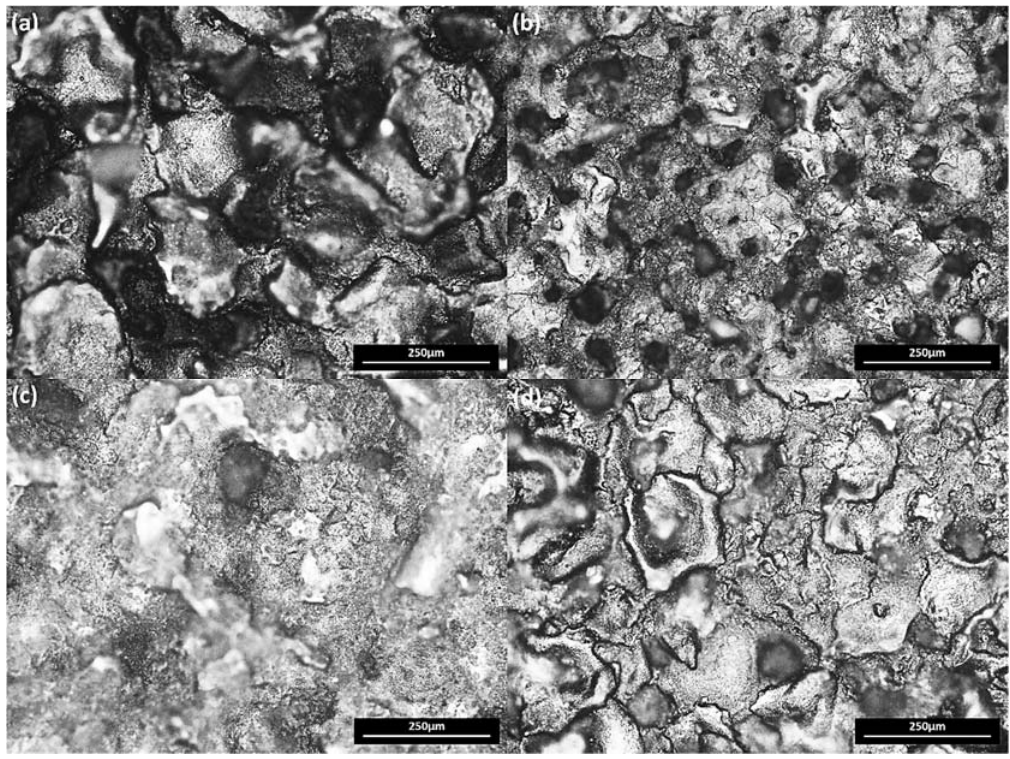
Figure 4. Surface Topography: Micrographs of Ti6Al4V ELI Grade 23 machined surface at 9 A pulse current on 200x magnification ( a ) EDM ( b ) PMEDM at 5g/L ( c ) PMEDM at 10g/L ( d ) PMEDM at 20g/L.